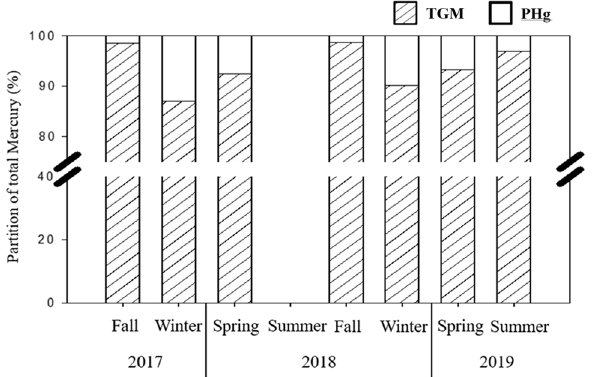
Figure 5. Gas-particle partition of atmospheric mercury at the Taiping Island for two-year measurement data.